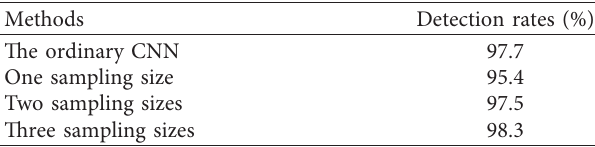
Table 1: Temperature and wildlife count in the three areas covered by the